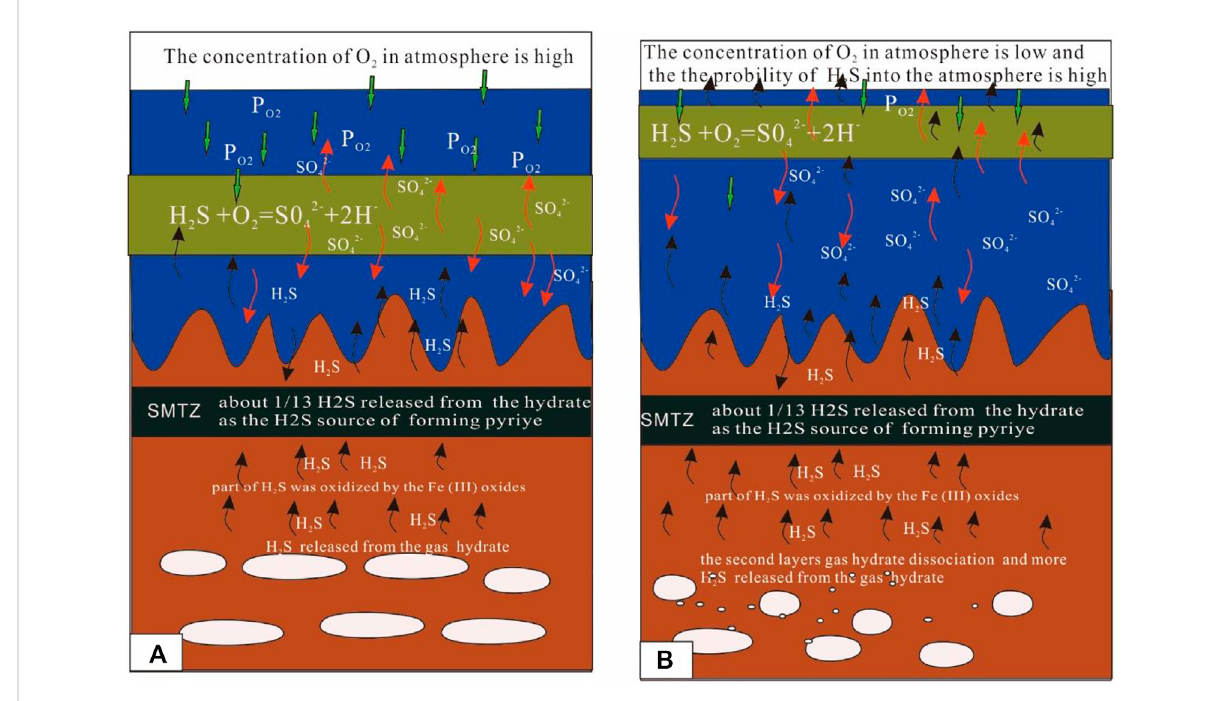
FIGURE 8 Mode of the sulfur cycle. The results show that a part of the H 2 S released from the dissociation of the gas hydrate is oxidized by Fe (III) oxide metal, with much of the metal ions being released into the pore water. Another part of the H 2 S is re-oxidized by the O 2 in the ocean, with much of SO 4 2- released into the seawater. Therefore, the process also provides metal ions and SO 4 2- to pore water or seawater when the H 2 S released from the gas hydrate diffuses from the bottom. The difference in A and B is the level of P O2 . In (A) , the P O2 is high and the released hydrogen sul fi de from the decomposition of hydrate fi nds it dif fi cult to enter the atmosphere. In (B) , the P O2 is low and the released hydrogen sul fi de from the decomposition of hydrate fi nds it easy to enter the